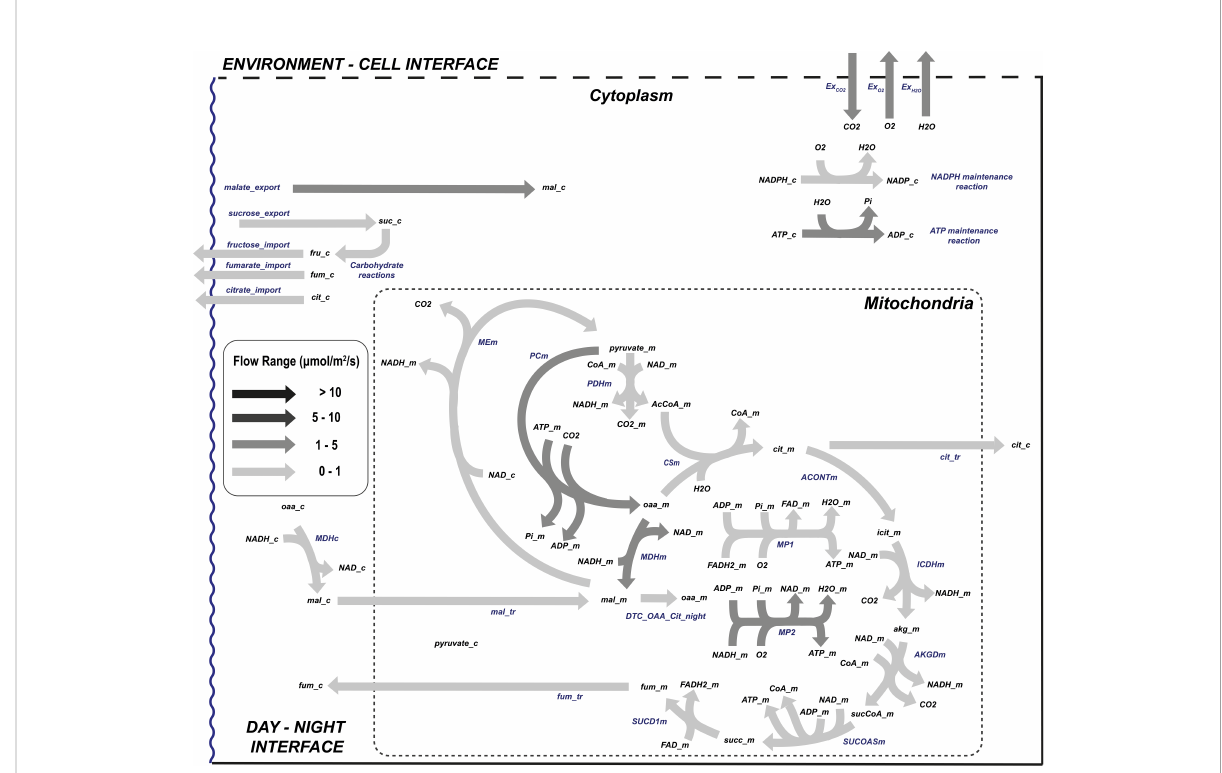
FIGURE 6 Flow distribution of the central carbon metabolism during L. sativa dark phase. List of abbreviated enzymes or enzyme reactions. In cytoplasm: MDHc, malate dehydrogenase; ICDHyc, NADPH isocitrate dehydrogenase; ACONT, aconitase; MEc, malic enzyme; CP1, glucose isomerase; CP2, sucrose-6-phosphate synthase. In mitochondria: ACONTm, aconitase; PDHm, pyruvate dehydrogenase; PCm, pyruvate carboxylase; CSm, citrate synthase; ICDHm, isocitrate dehydrogenase; AKGDm, a -oxoglutarate dehydrogenase; SUCOASm, succinyl-CoA synthetase; SUCD1m, succinate dehydrogenase complex; MDHm, malate dehydrogenase; MP1/2, mitochondrial phosphorylation